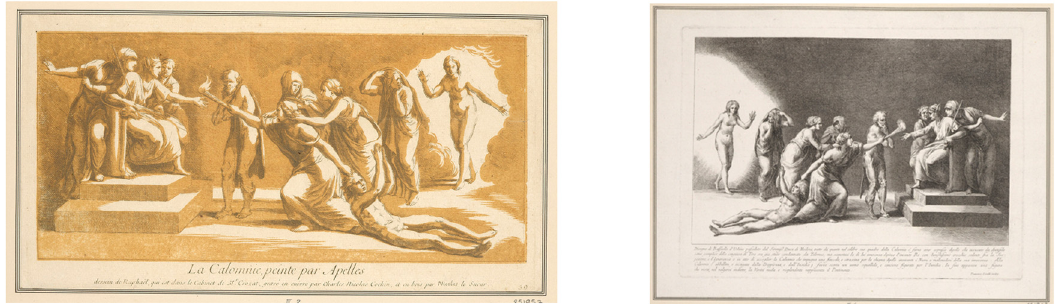
Figure 16: ( a and b ) Raphael, La Calomnie peinte par Apelles . British Museum, London. Public Domain.